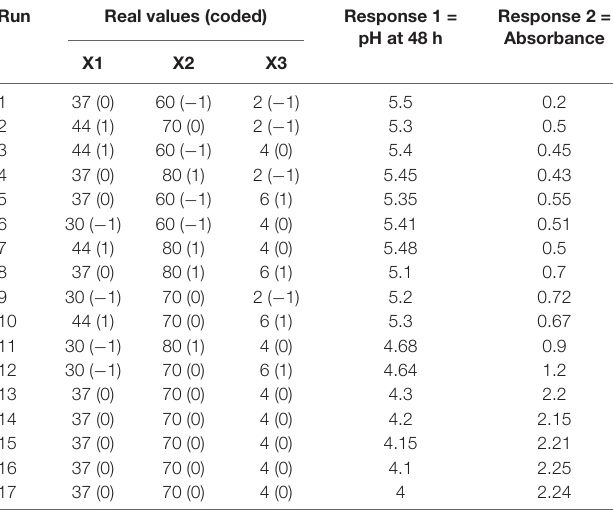
TABLE 1 | Independent variables and response data in the response surface method (RSM)